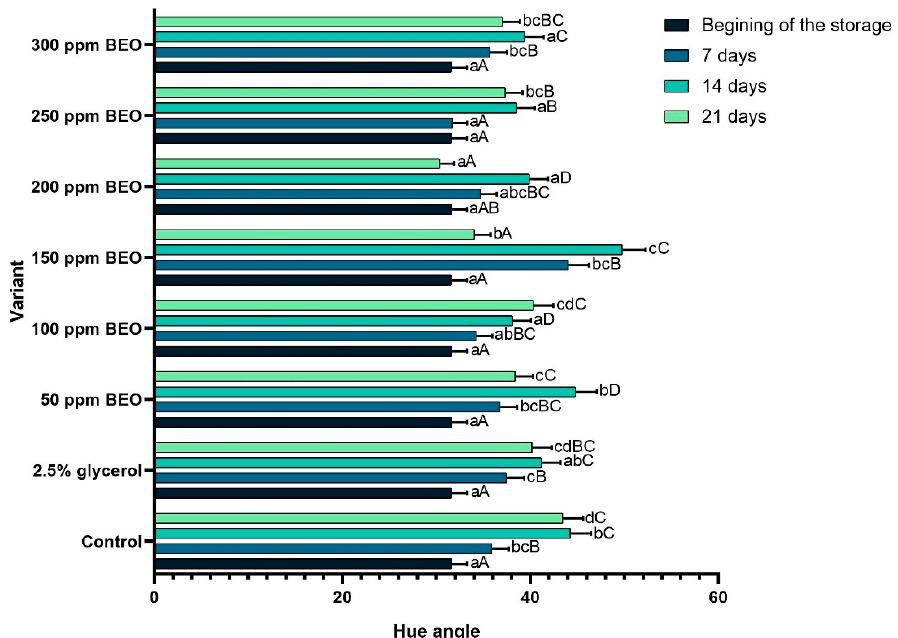
Figure 10. Effects of applied treatments on the Hue angle (fruit color parameter) during storage for 21 days at 8 ± 1 °C. Bars for the same sampling time followed by different lowercase letters are significantly different based on the least significant difference (LSD) test ( p < 0.05). Bars for the same treatment during storage time followed by different uppercase letters are significantly different based on the least significant difference (LSD) test ( p < 0.05).